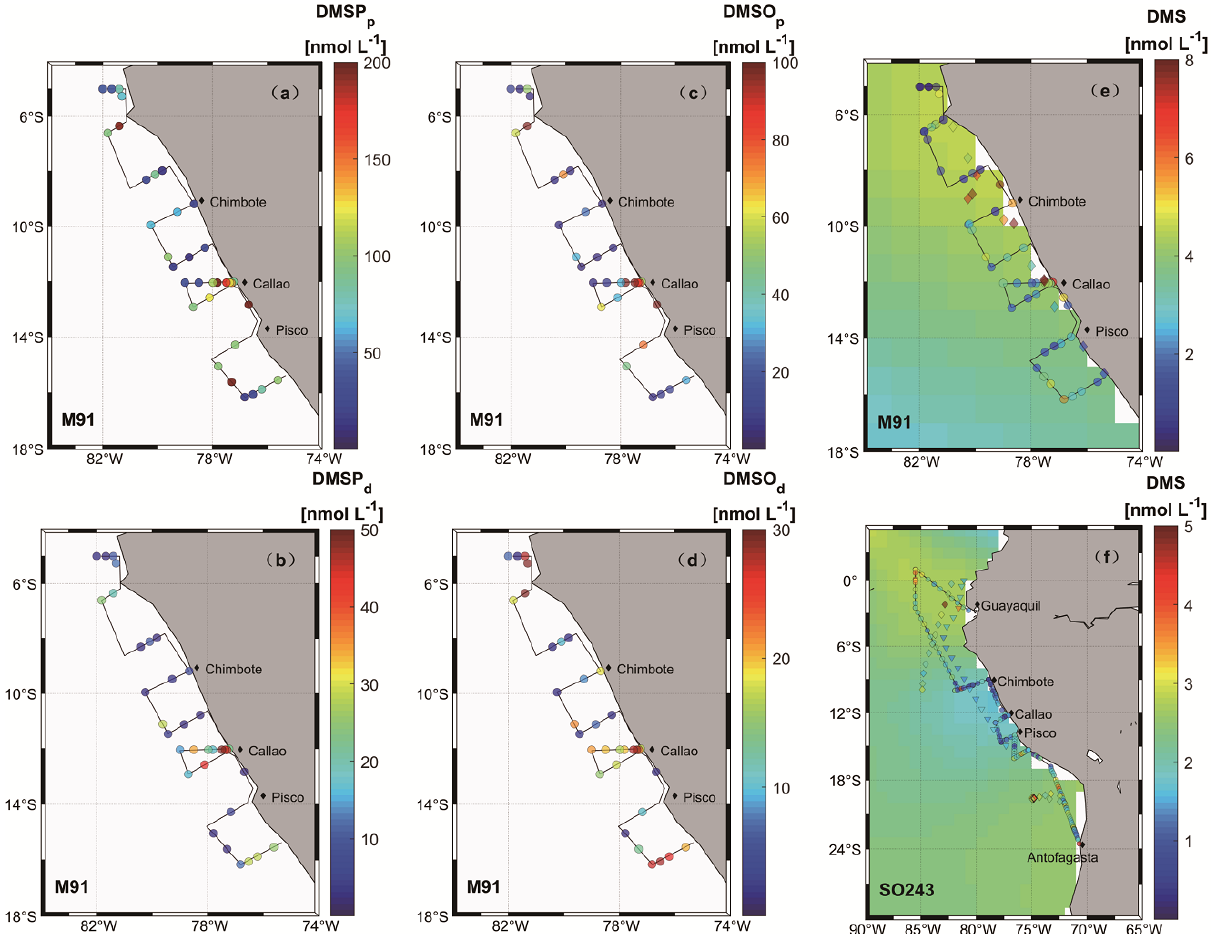
Figure 3. Surface seawater measurements of sulfur compounds are shown in panels (a) – (f) (circles) for DMSP p (M91), DMSP d (M91), DMSO p (M91), DMSO d (M91), DMS (M91), and DMS (SO243), respectively. Monthly (December and October) surface DMS concen- trations from the Lana et al. (2011) climatology are colour-coded in the background in (e) and (f) , respectively. Diamonds in panel (e) , as well as diamonds and triangles in panel (f) , are recorded DMS concentrations in adjacent waters retrieved from the PMEL database for June–July 1982 (Andreae, 1985), October–November 2007 (unpublished DMS data), and October–November 2008 (Hind et al., 2011), re- spectively. Note that to ensure readability of the plots, the scale in panel (e) is capped at 8nmolL − 1 with a few values exceeding the upper threshold, and DMS data retrieved from the PMEL database were averaged every 10